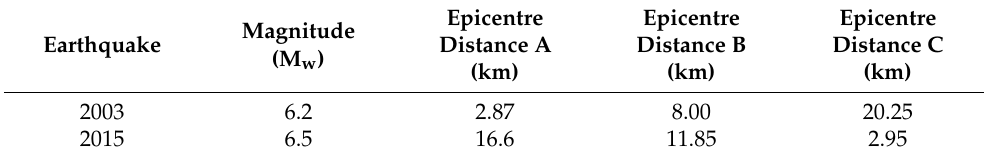
Table 4. Earthquake parameters of the two earthquakes discussed in this work.